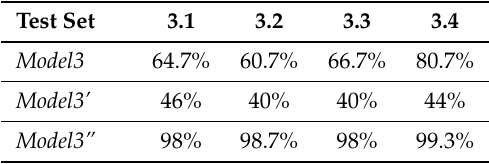
Table 4. Classification accuracies of the models on five